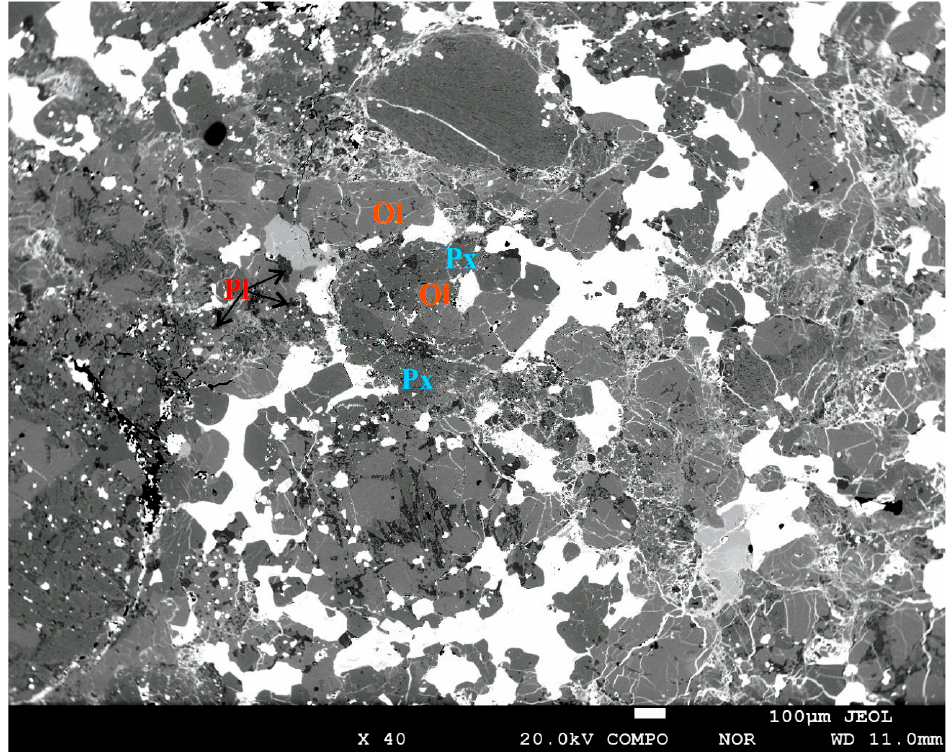
Figure 3. BSE image of 1PO ‐ 2 chondrule from the Kargapole meteorite.